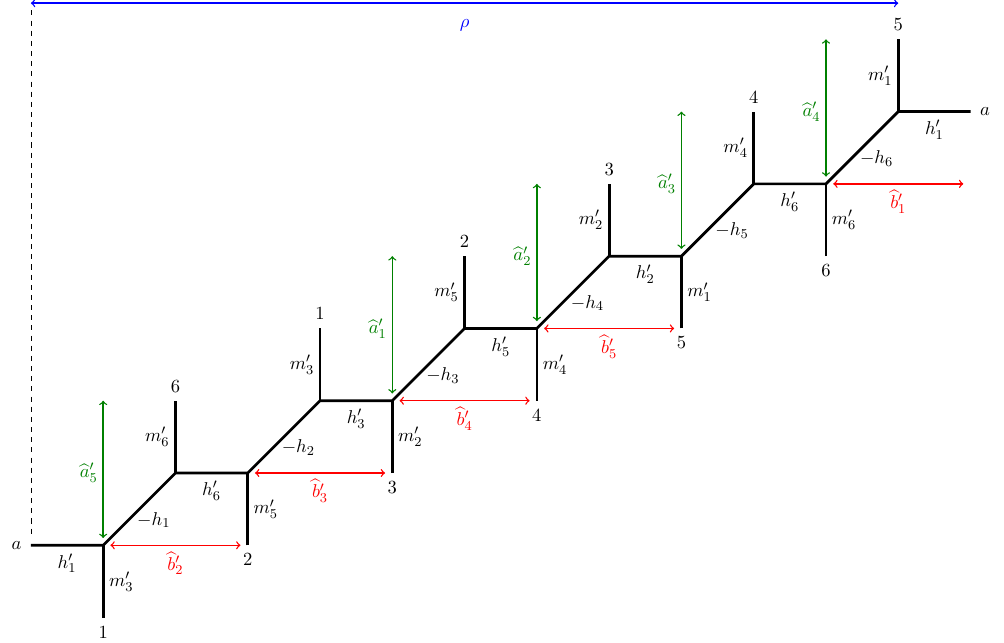
Figure 9 . Toric web diagram of X 6 ; 1 (with shift parameter (cid:14) = 0) with a consistent labelling of the areas of all